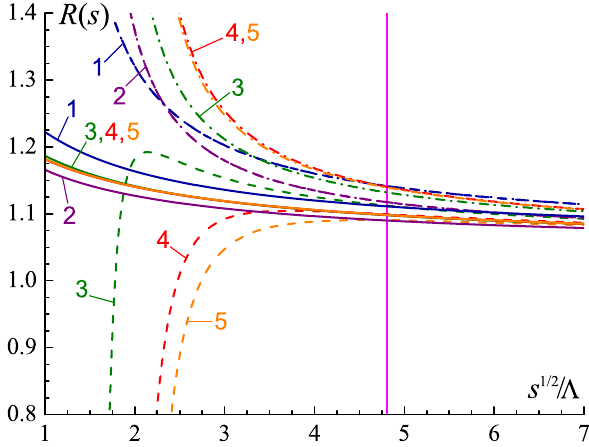
Fig. 6 Two-loop timelike effective expansion function of the second ( 2 ) ( s ) [Eq. (79), solid curve] and the approximations corre- order A TL , 2 spondingtovariousordersofitsre-expansion(85).Theresultof“naive” continuation (12) [the first term on the right-hand side of Eq. (85)] is shown by dashed curve. Numerical label next to a dot-dashed curve indicates the highest absolute value of power of ln w retained on the right-hand side of Eq. (85). The plotted functions are scaled by the fac- tor of 10. Vertical solid line marks the boundary of convergence range √ s /Λ = exp (π/ 2 ) (cid:3) 4 . 81 of the re-expansion (85) at